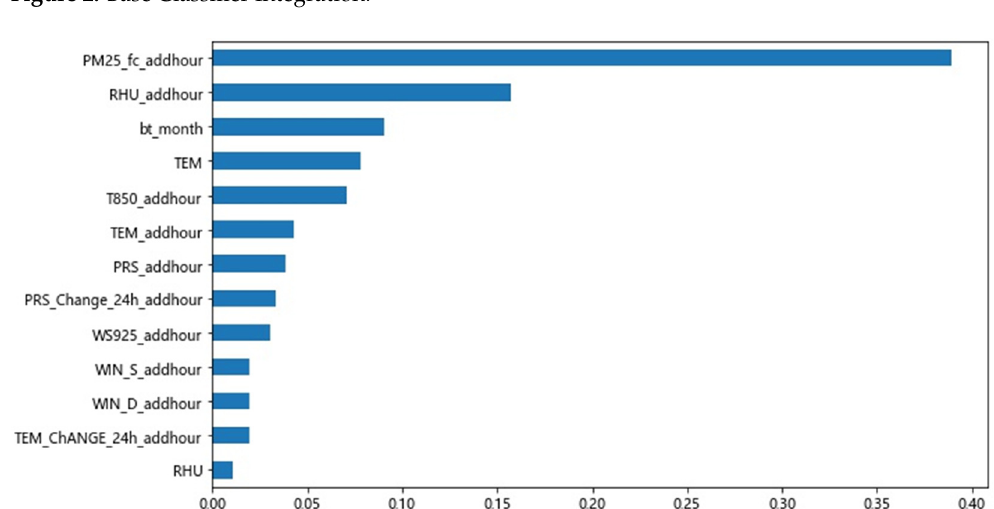
Figure 3. PM 2.5 Characteristic Figure 3. PM 2 . 5 Characteristic factor.